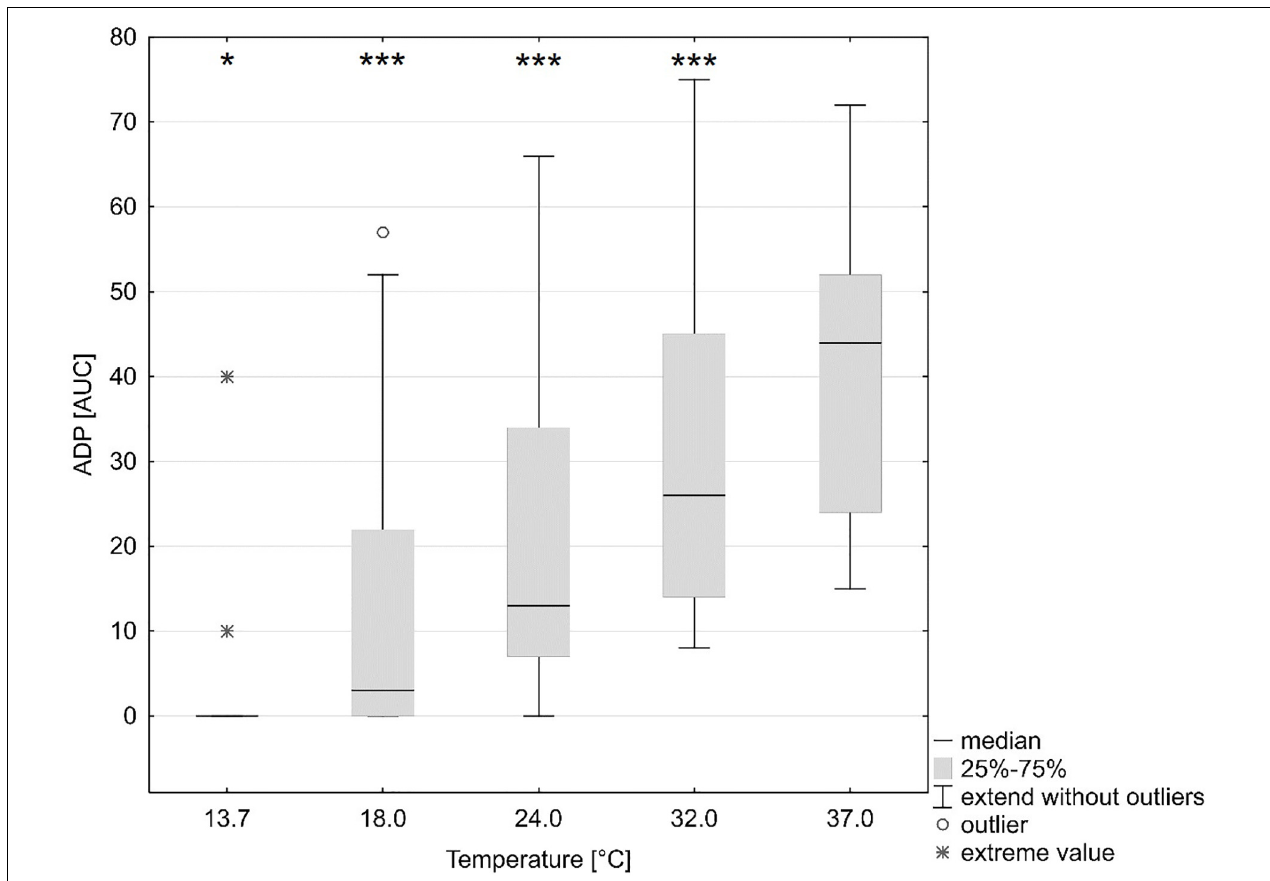
FIGURE 2 | Influence of temperature (x axis, temperature in degrees Celsius) on platelet function (y axis, ADP test multiple-electrode aggregometry, AUC area under the curve). ∗ p < 0.05, ∗∗∗ p < 0.001 indicates differences as assessed with the repeated measures ANOVA as compared to baseline (37 ◦ C). Figure shows median, 25 and 75% quartile, extended values, outliers and extreme values.